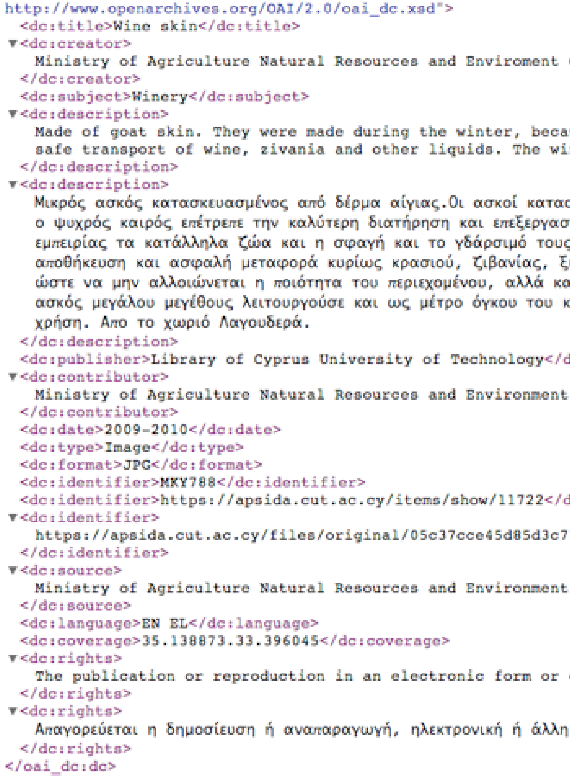
Figure 6 Enrichment services framework